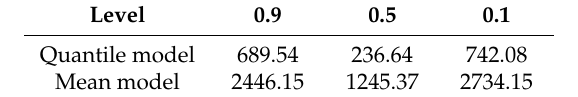
Table 1. Mean squared error (MSE) from proposed quantile and mean regression models.